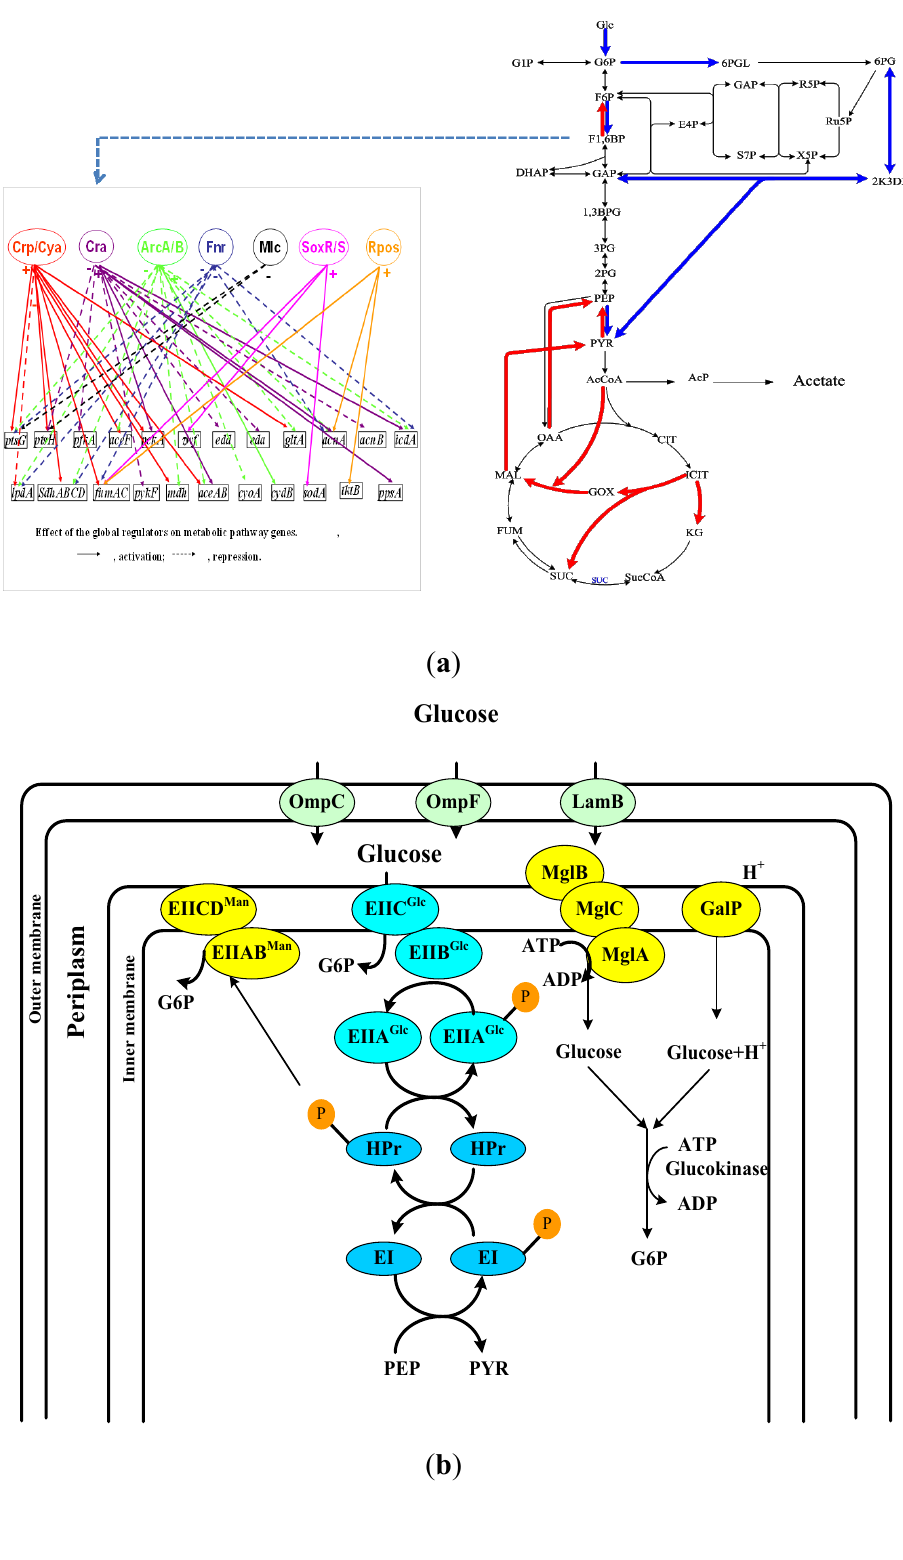
Figure 1. Main metabolic pathways and its regulation: ( a ) Control by TFs such as Cra; and ( b ) transport of glucose via PTS and non-PTS